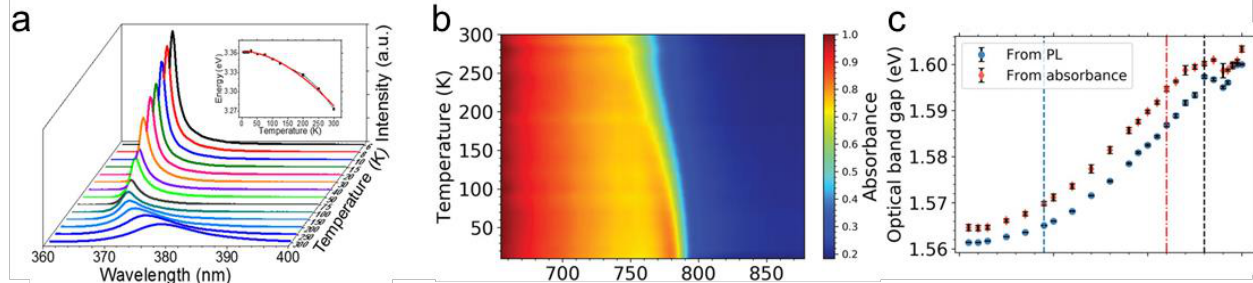
Figure 3. Cooling-enhanced phenomenon of absorption. ( a ) Temperature-dependent absorption of p-Si/n-ZnO photodetector. Inset: bandgap at various temperatures (adopted from [113], with permission from the American Chemical Society, 2017). ( b ) Temperature-dependent absorption of perovskite solar cells (adapted from [39], with permission from Wiley-VCH, 2019). ( c ) Temperature-dependent optical bandgap of perovskite solar cells (adapted from [39], with permission from Wiley-VCH, 2019).